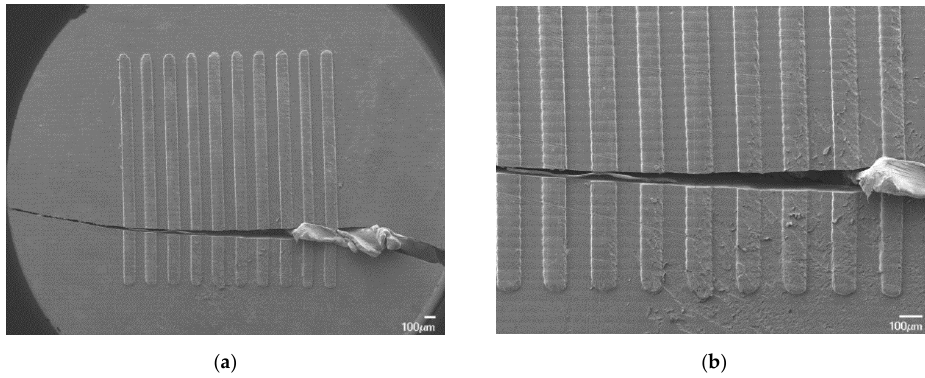
Figure10. SEMimagesofTool5 (cid:48) sGroupDchannelsexhibiting( a )brittlefailureand( b )thermal-induced surface